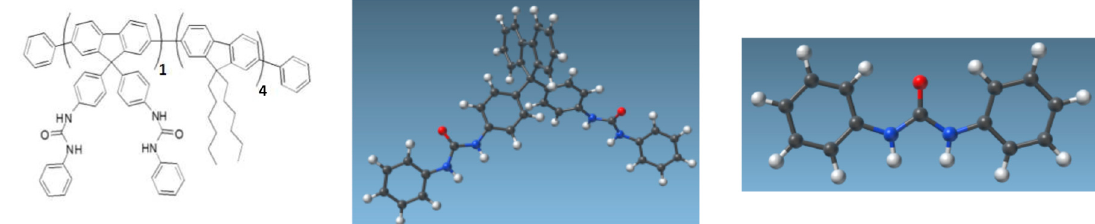
Figure 3. ( Left ): Chemical structure of FF-UR polymer. Adapted from [39], with the permission of AIP Publishing. ( Middle ): Fluorene monomer carrying two urea-based sensing moieties (SAMSON software). Reproduced from [40], with the permission of John Wiley and Sons. ( Right ): focus on the sensing moieties (SAMSON software). Atom color code: black for carbon, white for hydrogen, blue for nitrogen, red for oxygen. Reproduced from [40], with the permission of John Wiley and Sons.